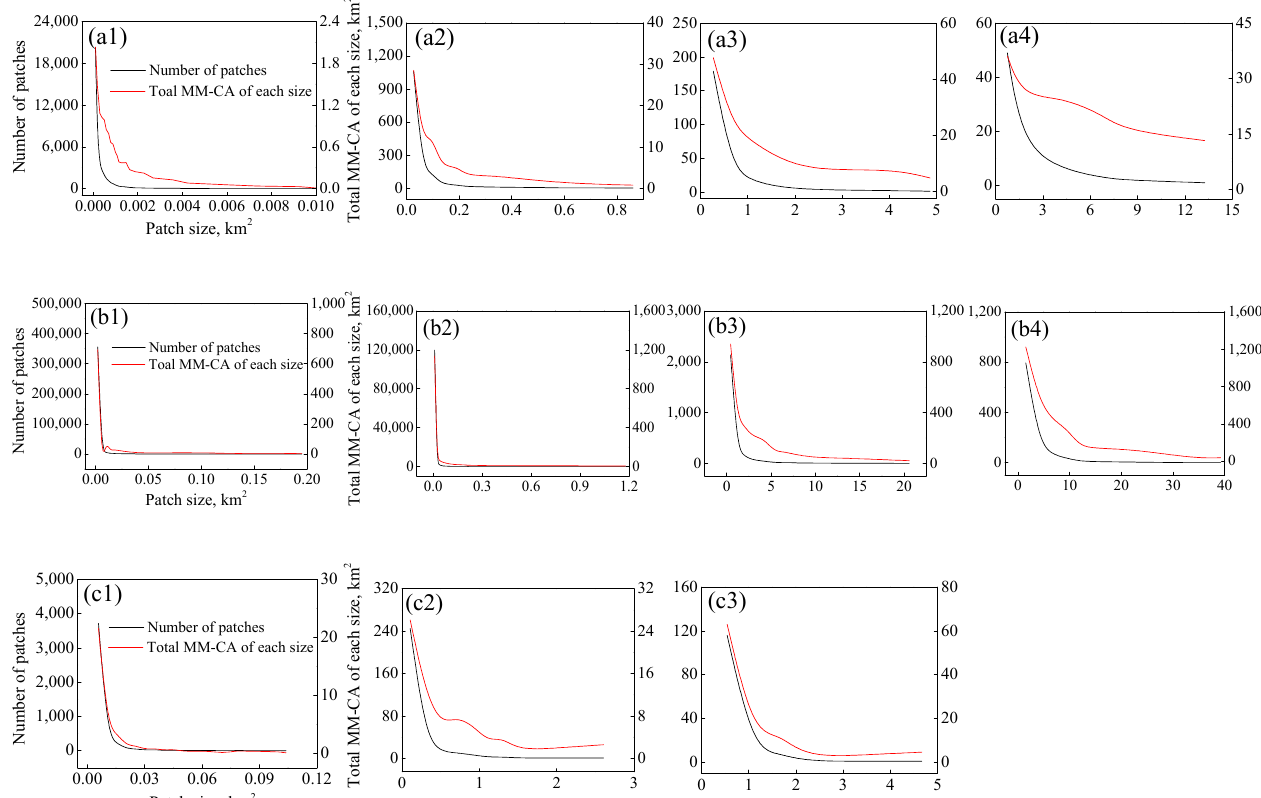
Figure 2. The number of patches and total MM-CA of different sizes. ( a1 – a4 , b1 – b4 , c1 – c3 ) are the images corresponding to A1–A4, B1–B4 and C1–C3 in Table 1, respectively.